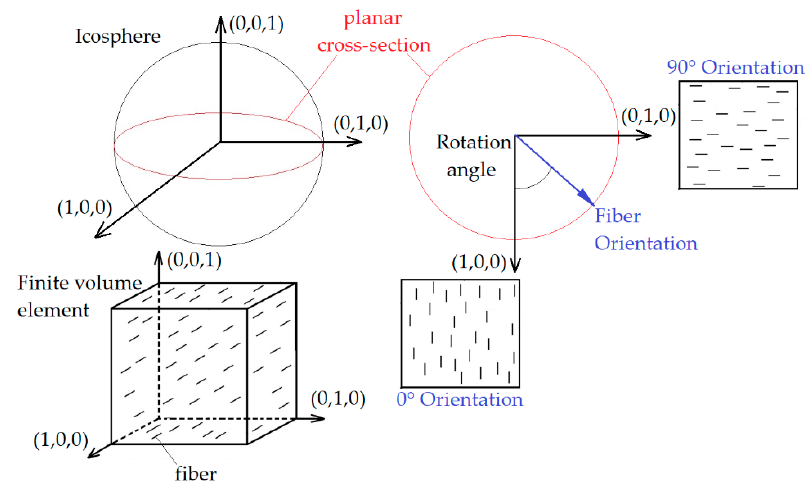
Figure 6. Finite ‐ element (FE) mesh of the discretized bending specimen with position of applied boundary conditions.